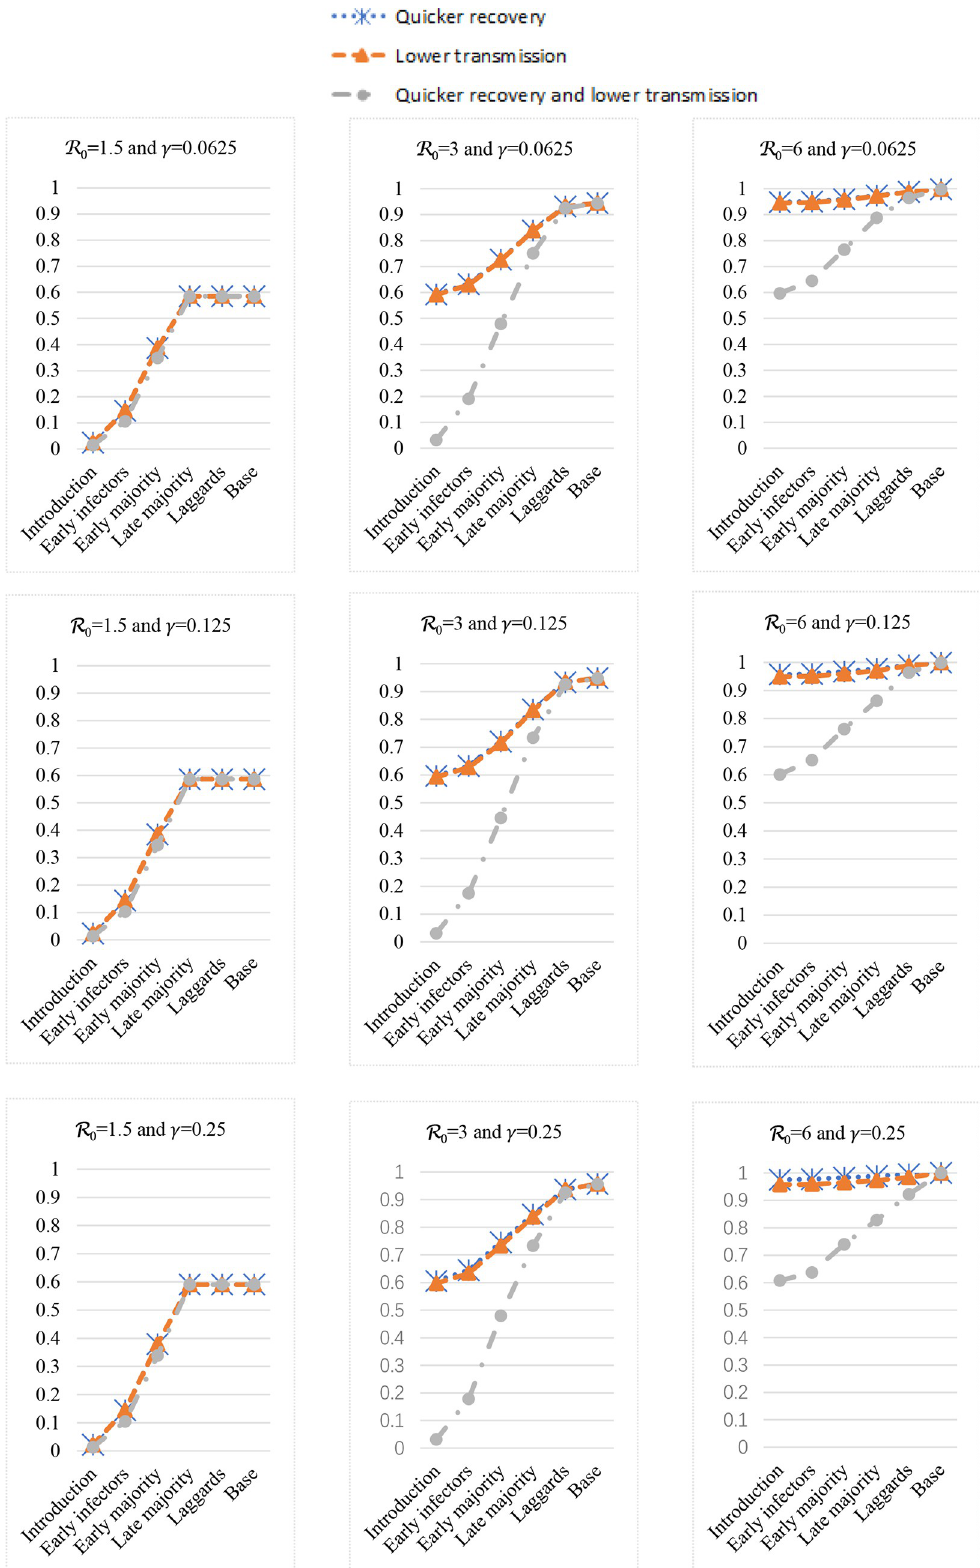
Fig 4. The cumulative infected (i.e., the recovered fractions or total infected) with different countermeasures. https://doi.org/10.1371/journal.pone.0280429.g004 PLOS ONE | https://doi.org/10.1371/journal.pone.0280429 January 26,